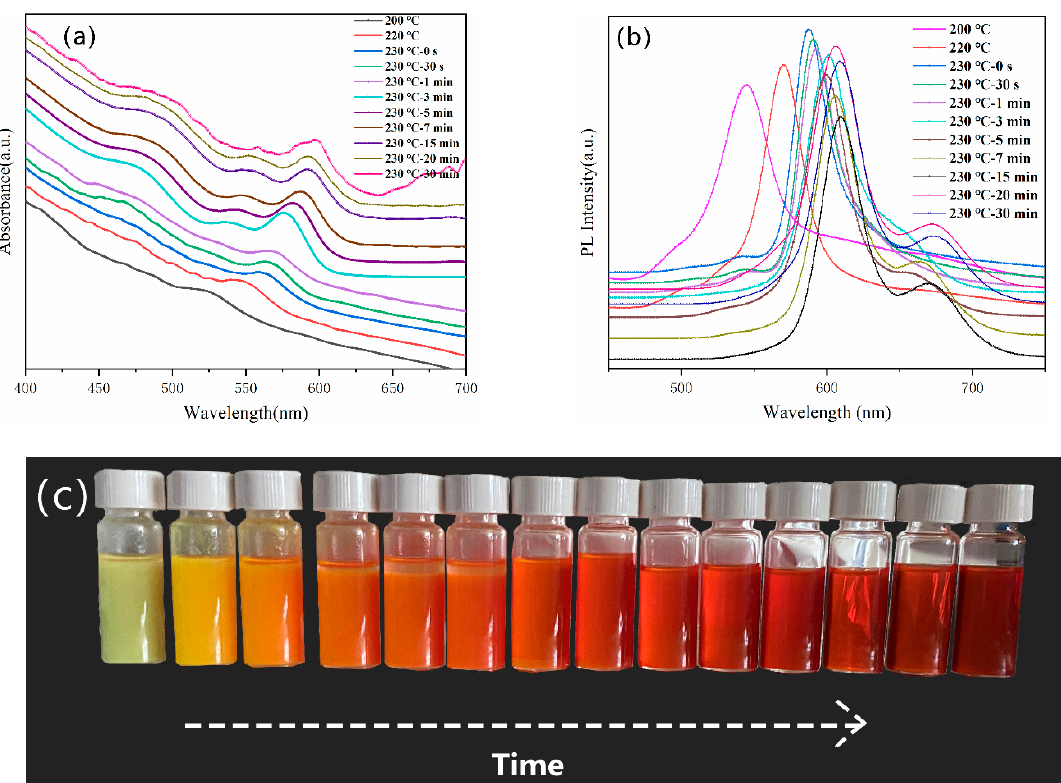
Figure 4. ( a ) UV absorbance of CdSe NCs with different growth time; ( b ) PL spectra of the CdSe NCs with different growth time; ( c ) PL images with excitation by 365 nm UV light.